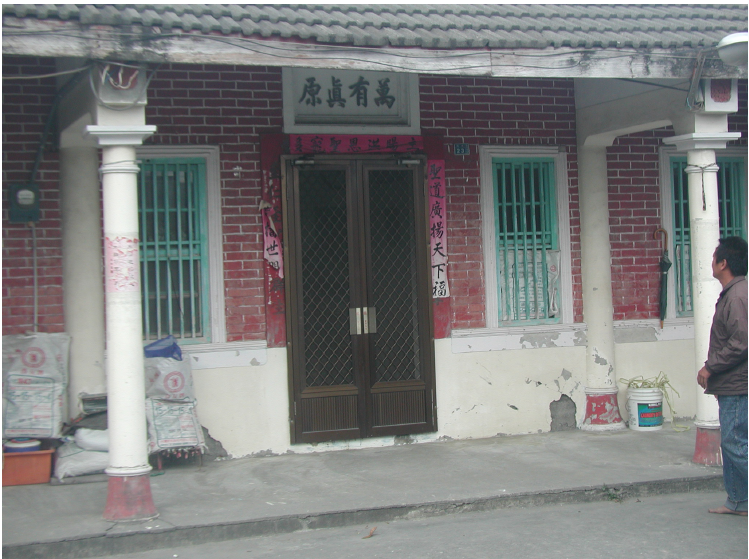
Figure 4. The characters in the lintel mean “The true origin of all things” 萬 有 真 原